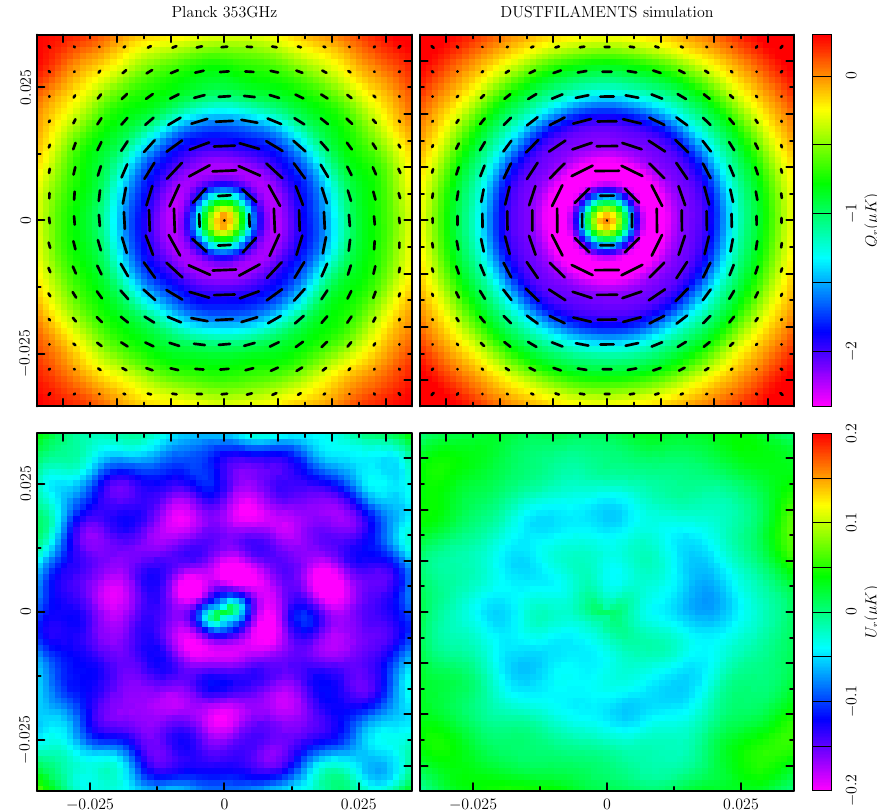
[ [ Figure 1. The stacked [ 2 ◦ ,2 ◦ ] 2 ◦ ,2 ◦ ] ( [ 0.035,0.035 ] 0.035,0.035 ] in radians) patches of − × − − × − Q r ( upper panels) and U r ( lower panels) around the hottest pixels that cover 5% 4 π steradian × in the LR63 mask. The colors represent the mean values, and the headless vectors in the upper panels show the polarization directions. The left column shows the Planck 353GHz half-mission 2 (100 (cid:46) (cid:96) 600 band-passed) polarization maps stacked around the hottest pixels of the Planck ≤ 353GHz half-mission 1 (100 (cid:46) (cid:96) 600 band-passed) intensity map. The right column shows the ≤ same for a DUSTFILAMENTS